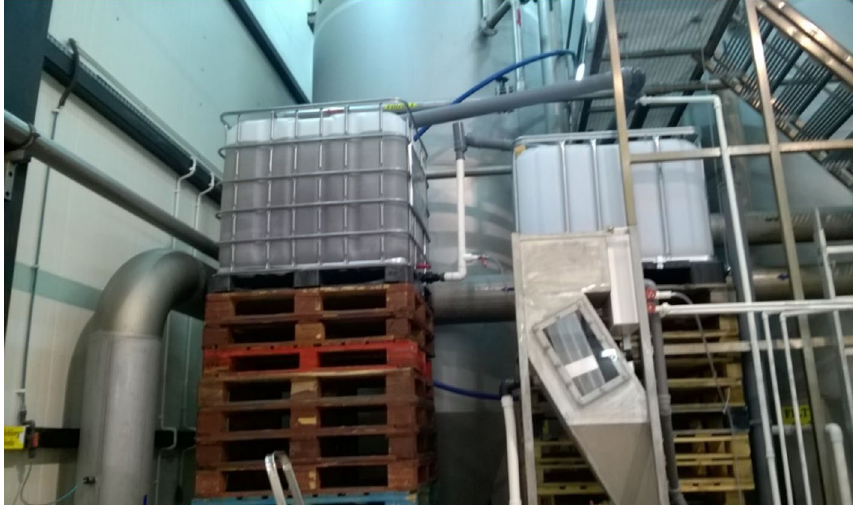
Fig. 4 Pilot station—two reac- tion chambers (chamber no. 1 filled with water) and a multi- stream settling tank